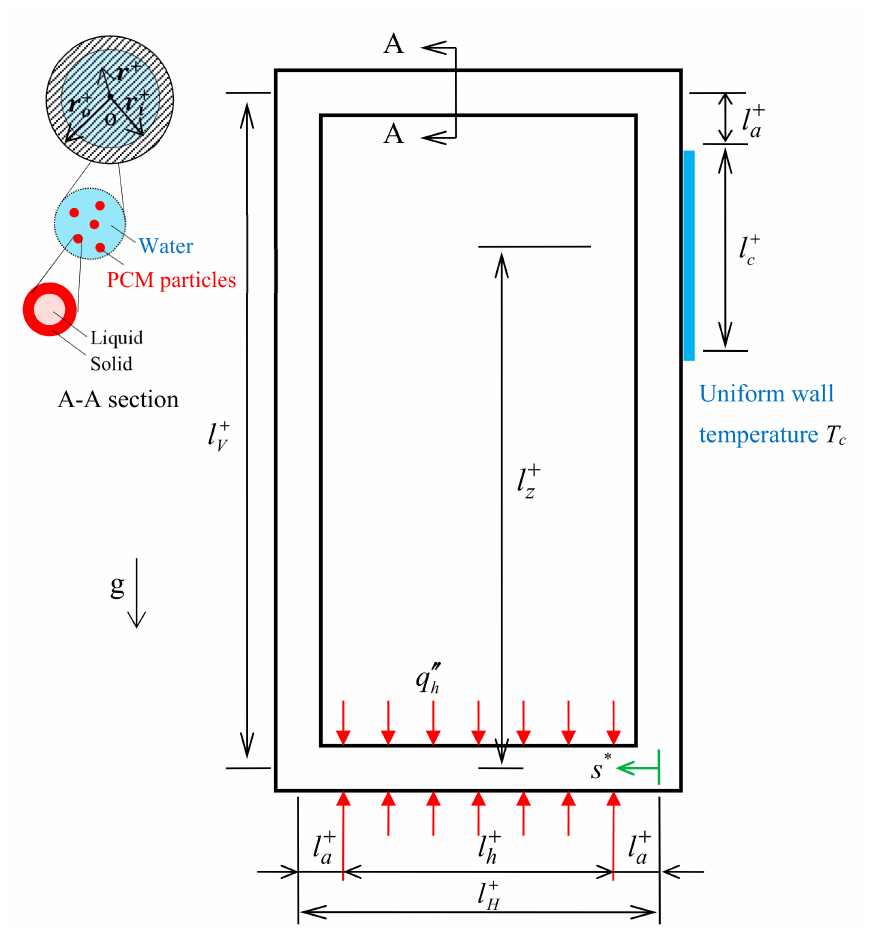
Figure 1. Schematic of rectangular thermosiphon loop and coordinate